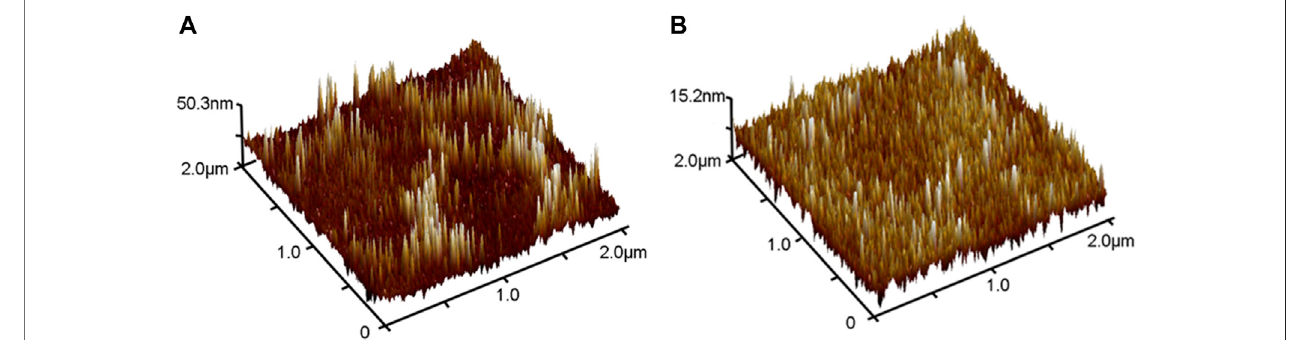
FIGURE 5 | AFM images of stripped LN thin fi lms after annealing at (A) 240 ° C and (B) 275 °